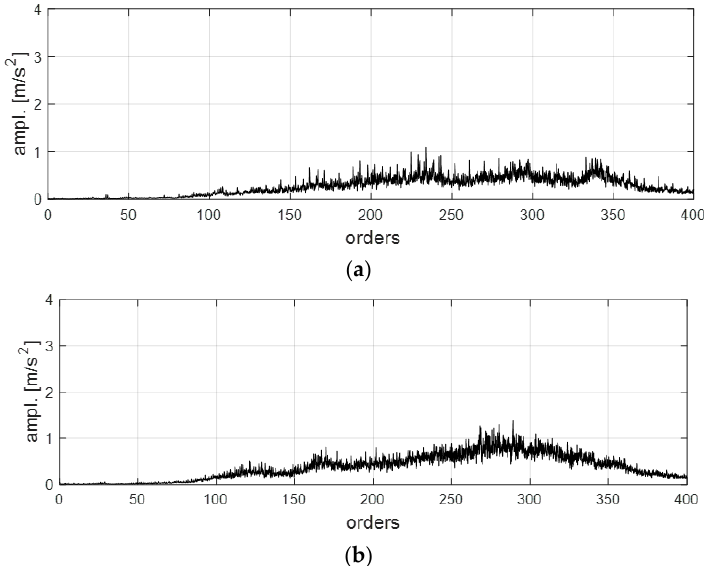
Figure 10. FFT of the residual signal for ( a ) the flawless pump and ( b ) faulty pump for the signal acquired with sensor 1 (1500 r/min, 150